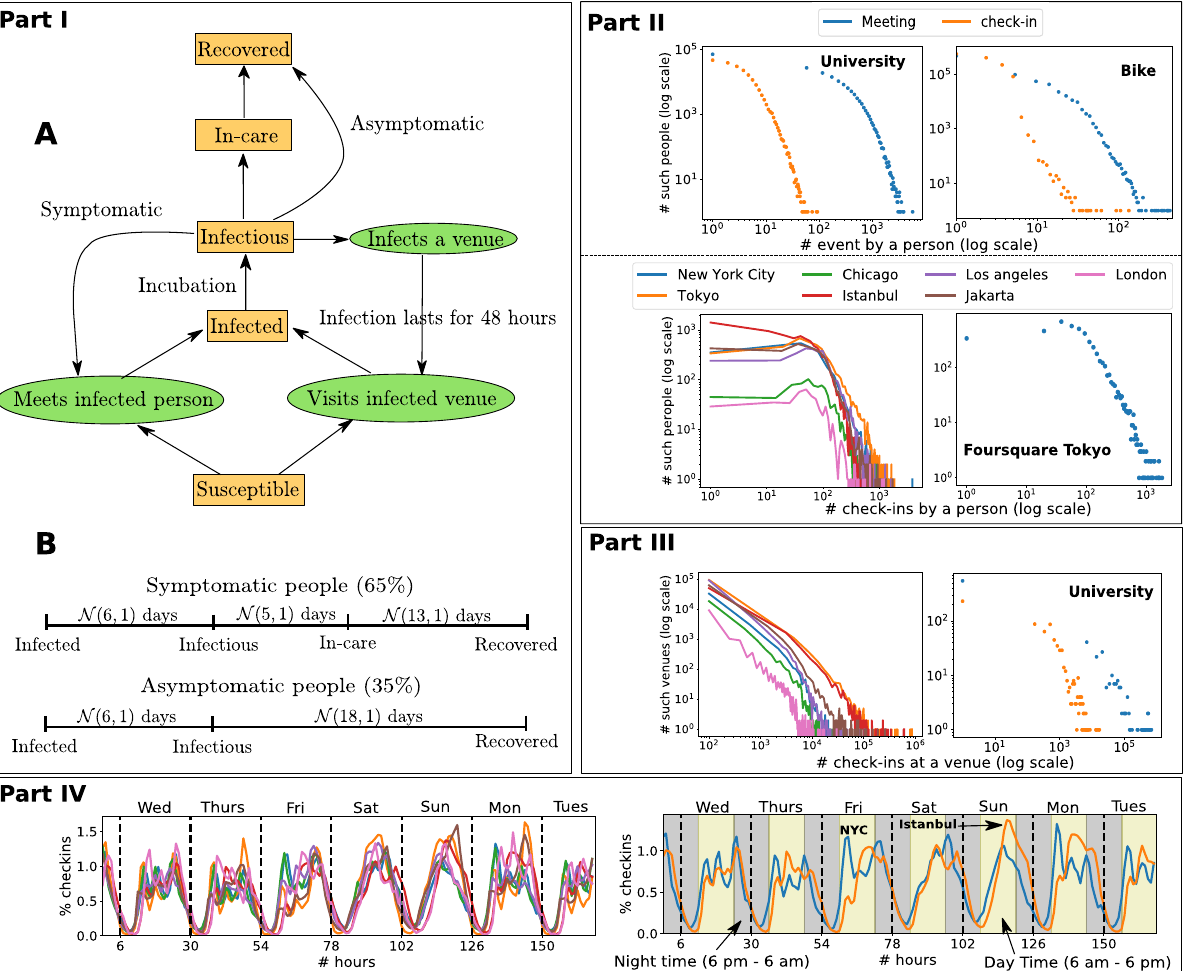
Figure 1. The model for infection spread (Part I) and dataset properties (Part II to IV). The model ( A ) is adapted from SEIR infection spread model and the parameters ( B ) are from CDC for COVID-19. The model states and actions are represented by boxes and ovals respectively. Part II and III present distributions of the number of check-ins or meetings per person and per venue, depicting the heterogeneity of mobility. Part IV: Normalized check-in counts aggregated over a week for all Foursquare datasets show daily patterns with increased activity on weekends. Patterns vary across